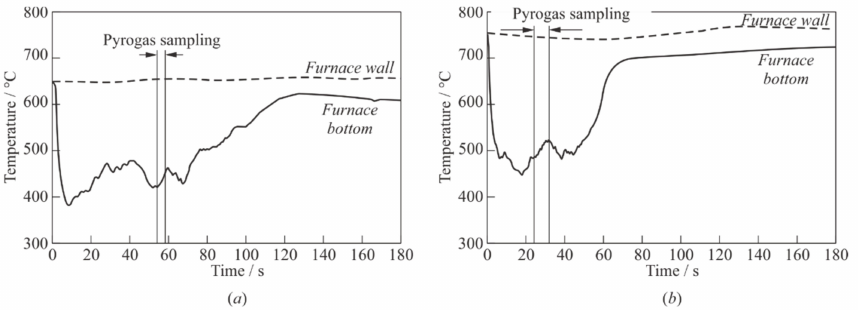
Figure 5. Examples of records of the pyrogas temperature (weighed sample of granular PE is 15 g) in an open GG at decomposition temperatures of 650 ( a ) and 750 ◦ C ( b ). Vertical lines correspond to the time interval during which a pyrogas sample is taken for chromatography. Table 5. Pyrogas composition (% (vol.)) during pyrolysis of granular PE in an open GG at m 0 = 15 g. T p ( ◦